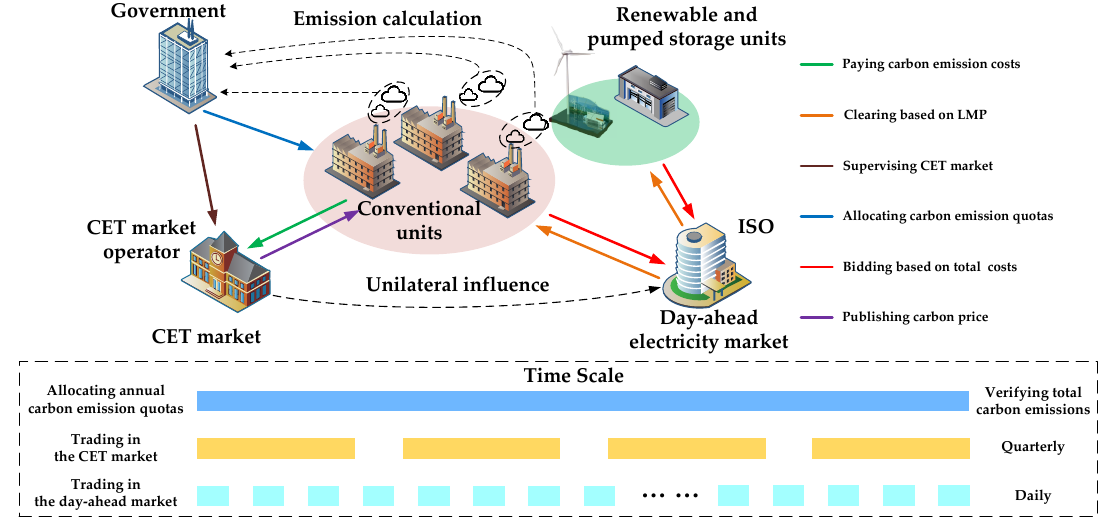
Figure 1. Market framework considering the interaction between carbon emission trading (CET) market and day-ahead electricity market.